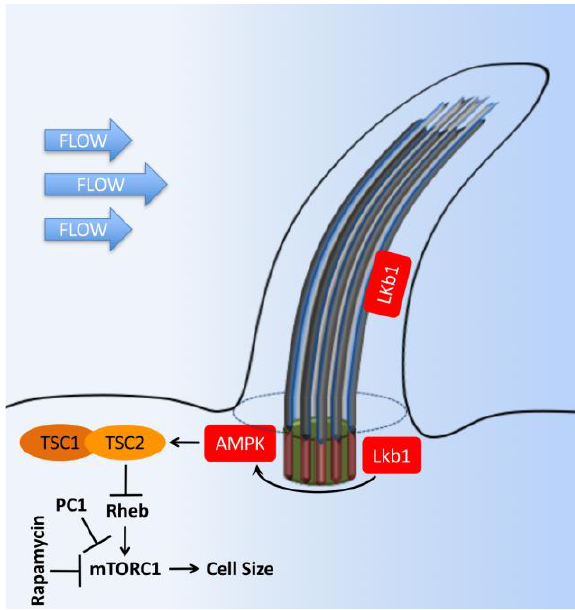
Figure 8. Cilia-dependent mTOR signaling. Flow shear stress mediates the bending of primary cilia and inhibition of mTORC1. Tumor suppressor kinase (LKB1) and AMP-dependent protein kinase (AMPK) are found in the cilia and basal body. Upon cilium bending by fluid flow, LKB1 is activated and transported into the basal body, where AMPK is phosphorylated. Furthermore, AMPK phosphorylates TSC2 to activate the TSC1–TSC2 complex. In turn, TSC1–TSC2 stimulates the GTPase activity of Rheb, preventing it from activating mTORC1. Otherwise, AMPK could also directly antagonize mTORC1. Polycystin-1 (PC1) may also exert its inhibitory effect on the mTORC1 pathway through its known interaction with TSC2. The T bars denote inhibition of protein function.